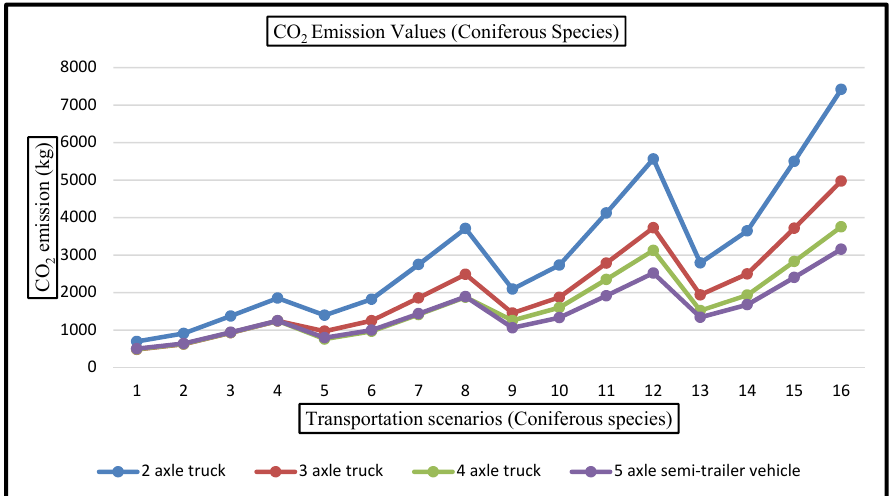
Forests 2022 , 13 , x FOR PEER REVIEW